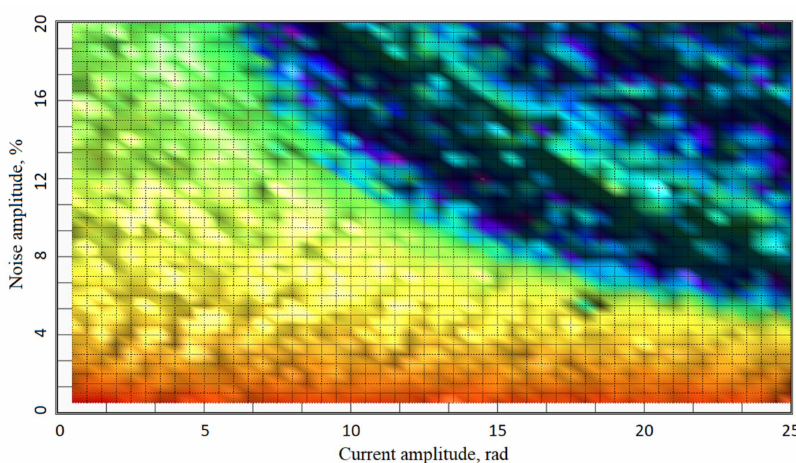
Figure 23. Current signal amplitude vs. noise % accuracy